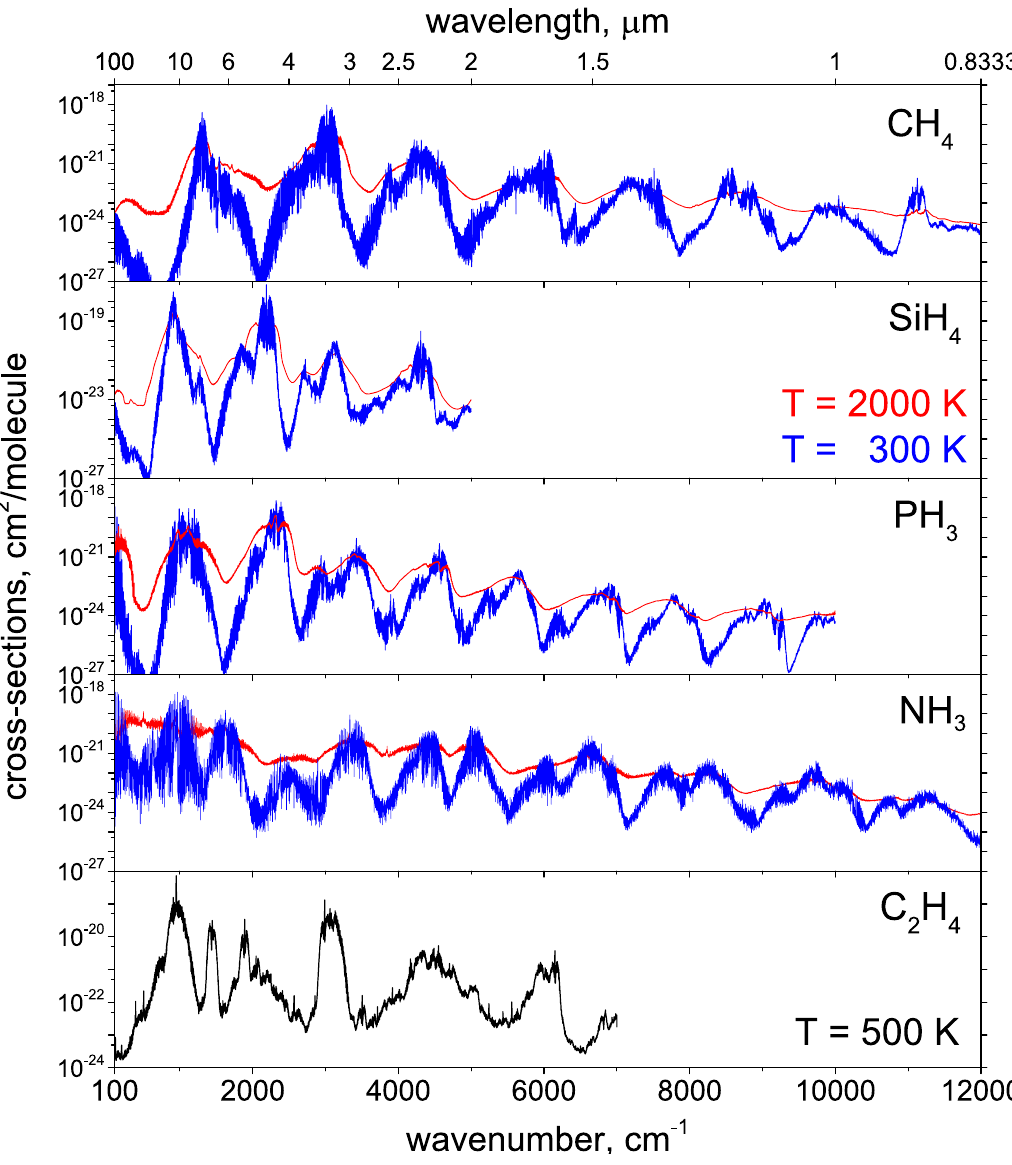
Figure 2. Cross sections generated using ExoMol line lists for methane, 10to10 line list [53], silane [72], phosphine [56], ammonia [79] and ethylene